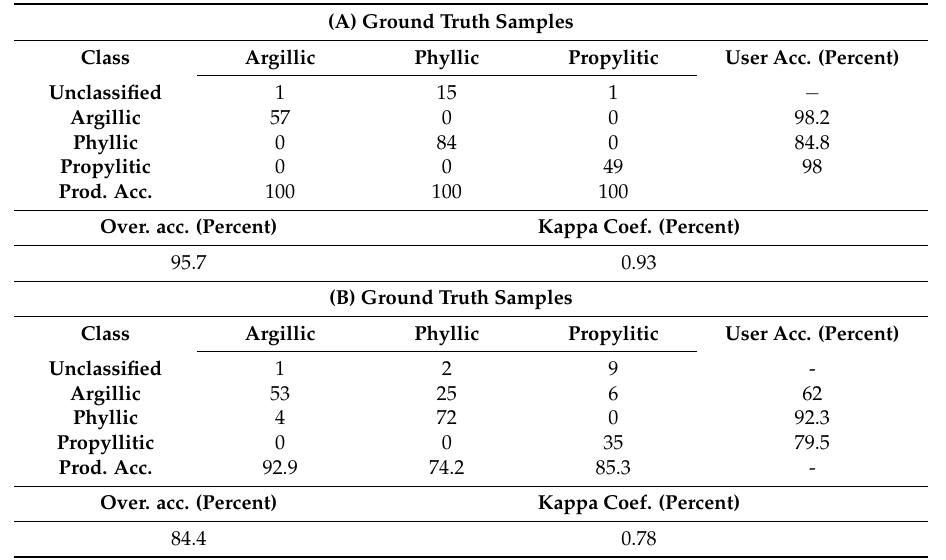
Figure 3. Reference endmember spectra of hematite, jarosite, montmorillonite, illite, muscovite, and chlorite obtained from the USGS spectral library for mapping alteration zones in the study area. The reference spectra were resampled to the response function of ASTER bands. The ASTER band center positions are also shown. Table 5. ( A ) The accuracy assessment for the Mixture Tuned Matched Filtering (MTMF) method based on GPS survey collected during the field study. ( B ) The accuracy assessment for the Spectral Angle Mapper (SAM) method based on GPS survey collected during the field